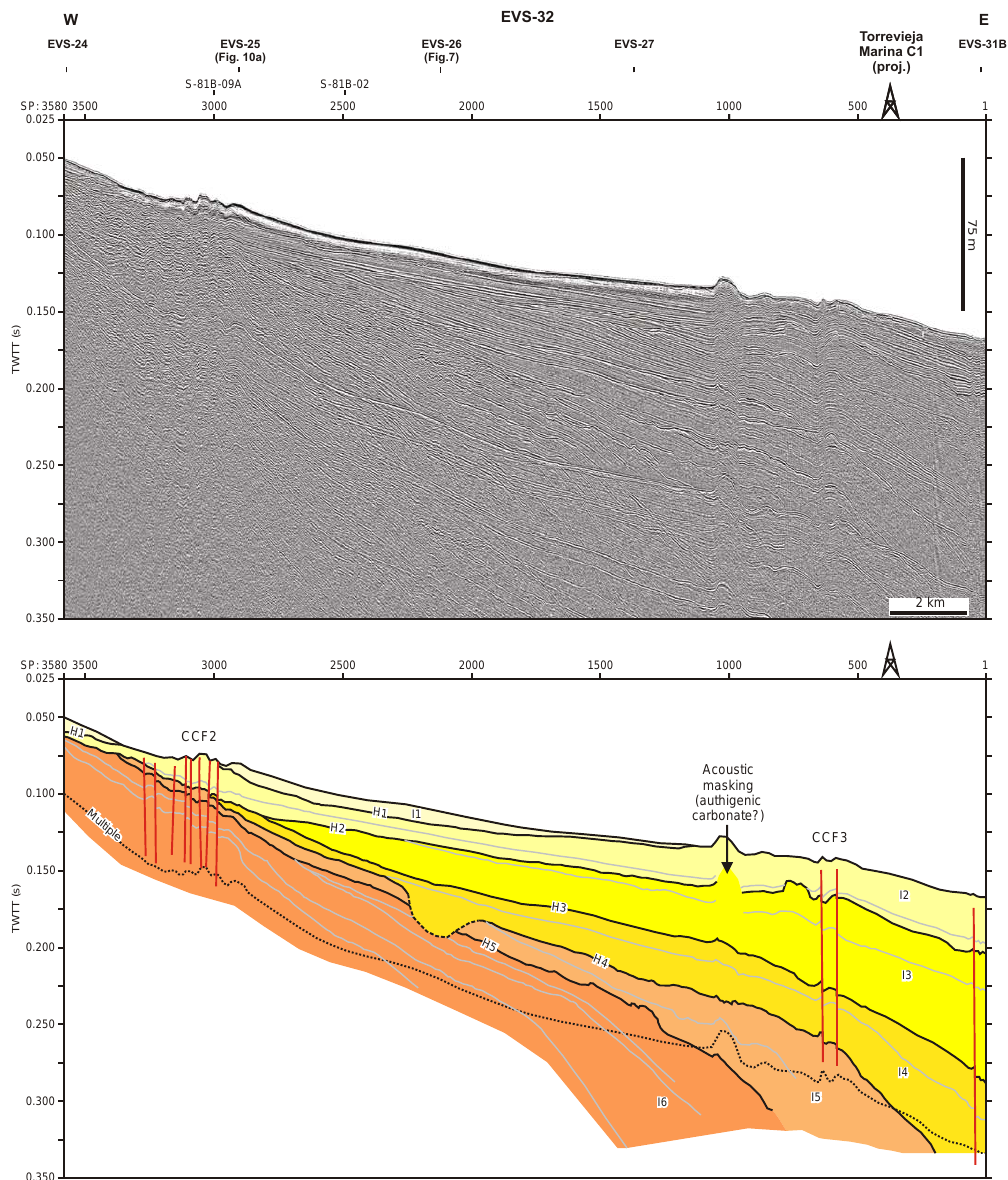
Fig. 5. SCS sparker profile EVS-32 and relative line drawing showing the identified seismo-stratigraphic units and structures. Note that the Figure 5 CCF2 (Fig. 8) fault zone is offsetting the seafloor surface, thus demonstrating the recent activity on this fault zone. Around shot point (SP) 1000, there is an acoustic masking facies that could be related to authigenic carbonates (Lo Iacono et al., 2011). The position of the Torrevieja Marina C-1 well is projected. See profile and well location in Figs. 2 and